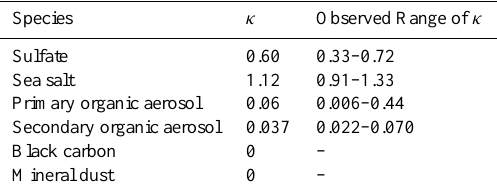
Table 6. Values of the hygroscopicity parameter κ used in ECHAM- HAM2 for the κ -K¨ohler theory based water uptake scheme. The ob- served ranges of κ listed in the rightmost column are quoted from Table 1 in Petters and Kreidenweis (2007), which were derived from the laboratory measured growth factor of particle radius. For pri- mary organic aerosols, the observed range is obtained from mean κ values of various organic compounds other than secondary organic